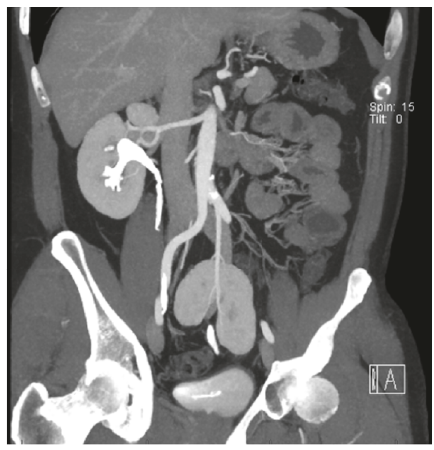
Figure 1: CT scan with coronal image of ectopic left pelvic kidney showing the middle polar artery.